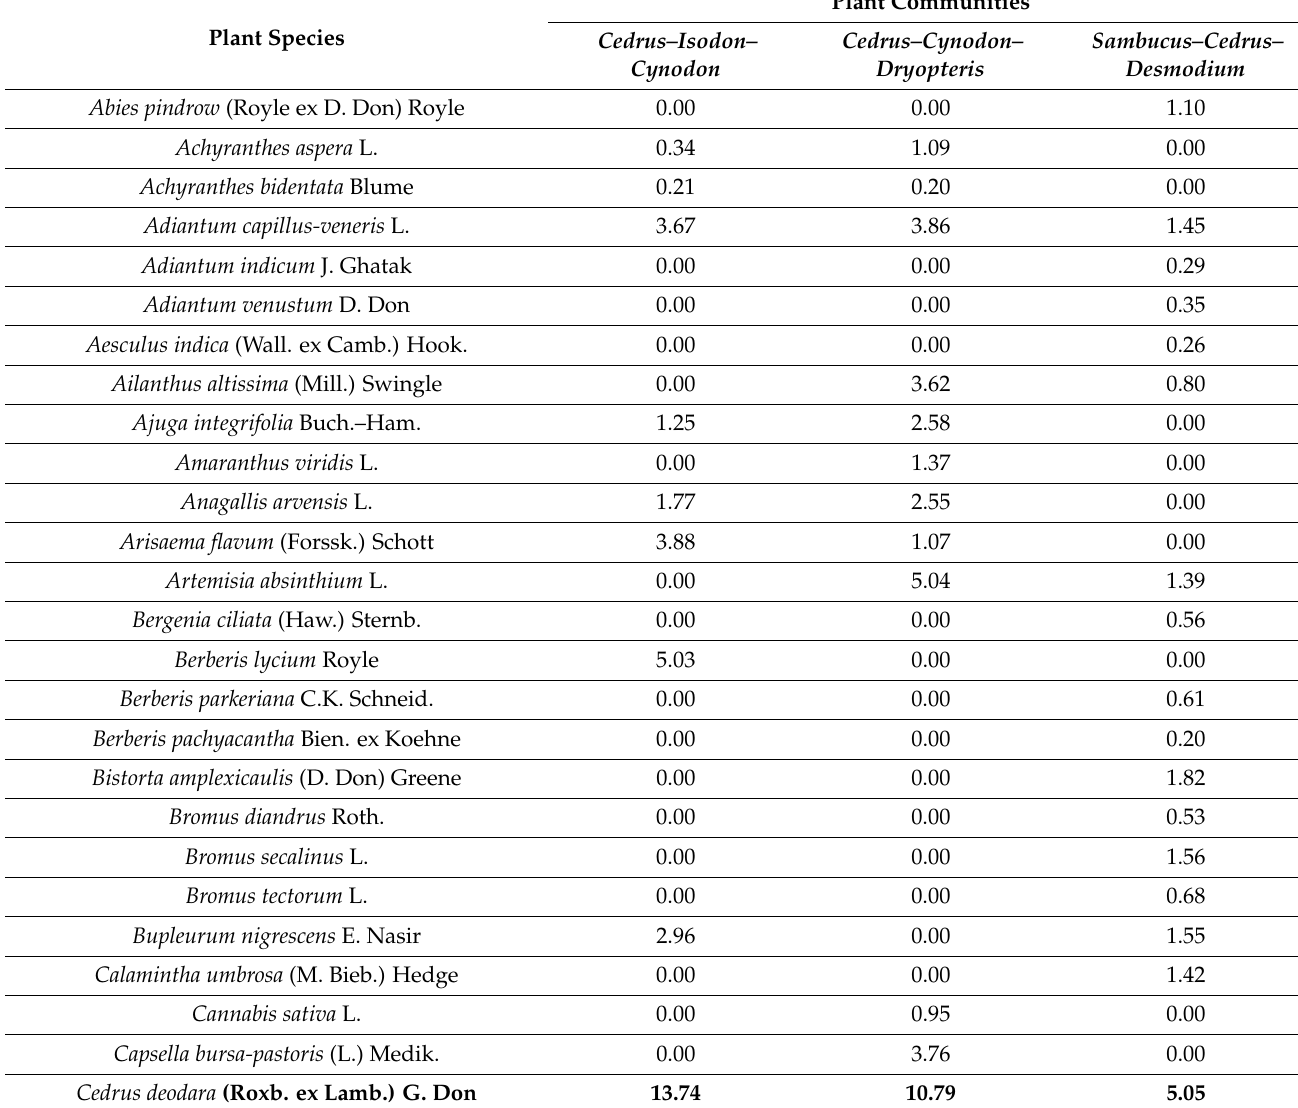
Table 1. List of plant species, with their importance values (IVs) calculated based on vegetative characteristics of each stand. Plant communities were named based upon three dominant species. The indicator species’ IVs are mentioned in bold, as well, with respect to plant